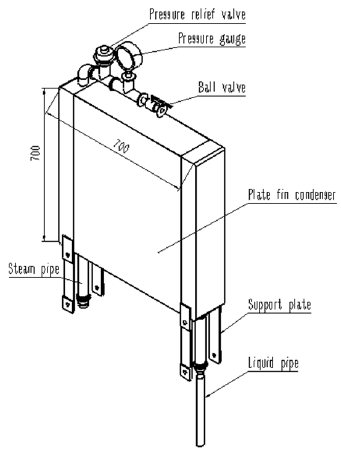
Figure 6. Assembly diagram of plate fin condenser.